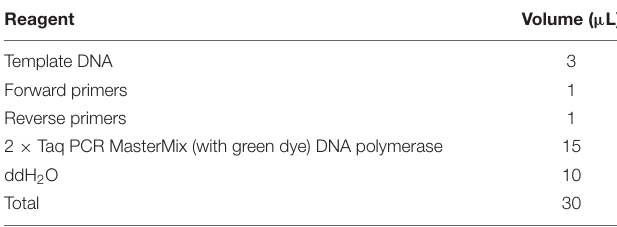
TABLE 3 | PCR system for amplifying the COI sequence.